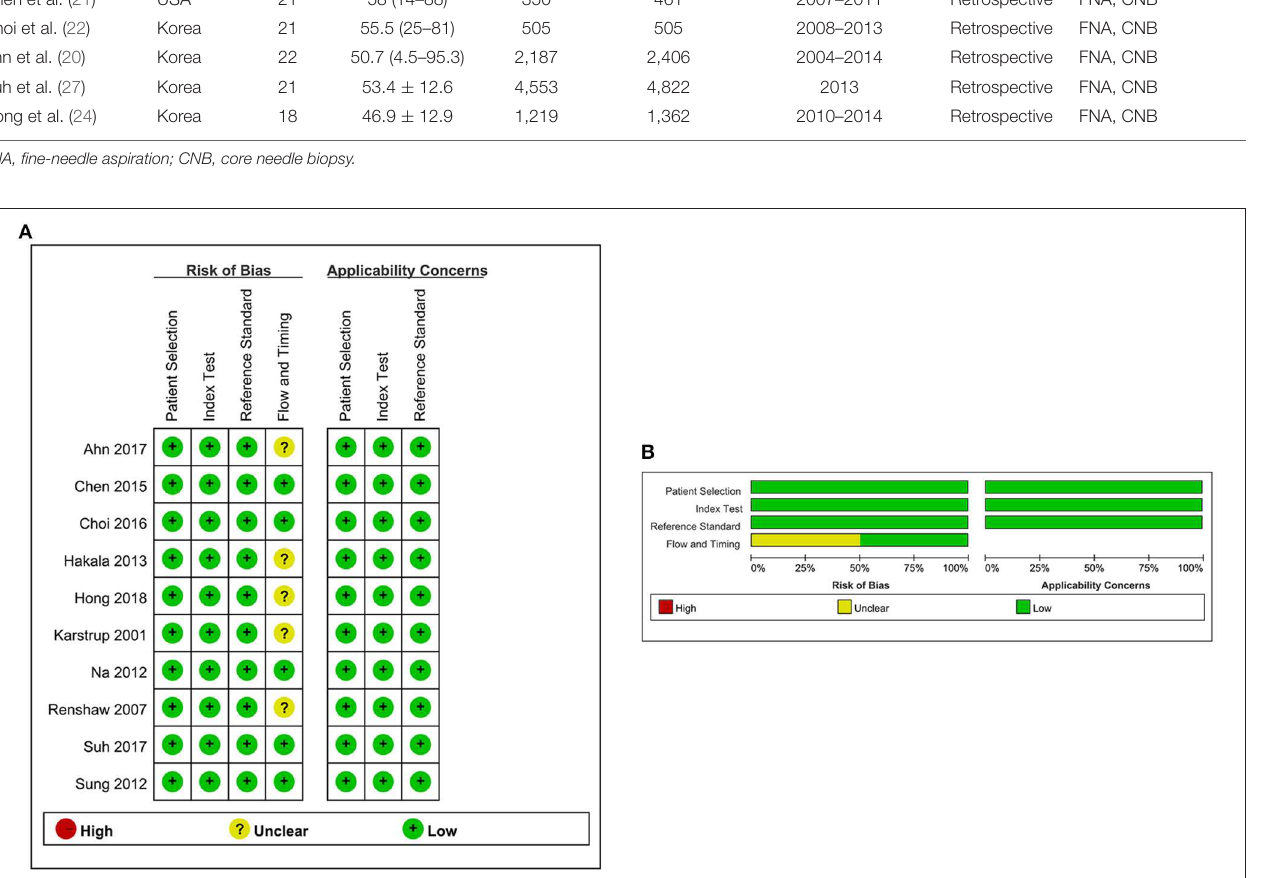
FIGURE 2 | Risk-of-bias and applicability concerns summary for each domain of the QUADAS-2 for each included study. (A) Risk-of-bias summary. (B) Risk-of-bias graph. Symbols. ( + ), low risk of bias; (?), unclear risk of bias; (–), high risk of bias.